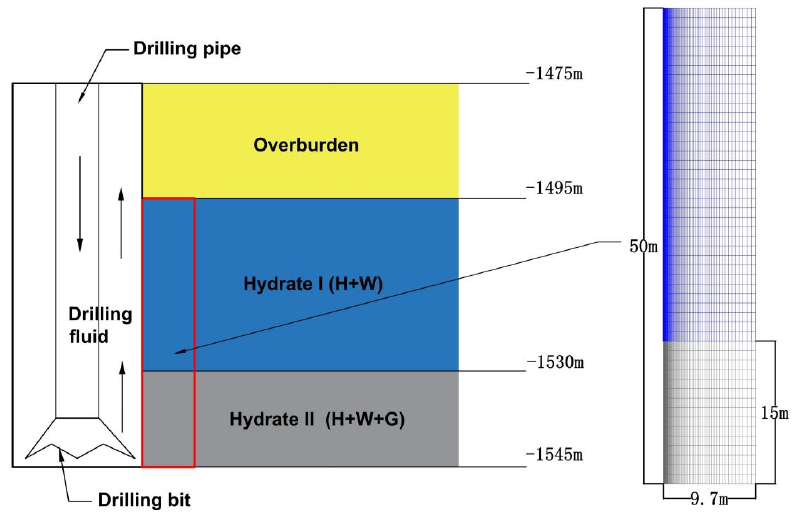
Figure 3. Grid structure diagram.